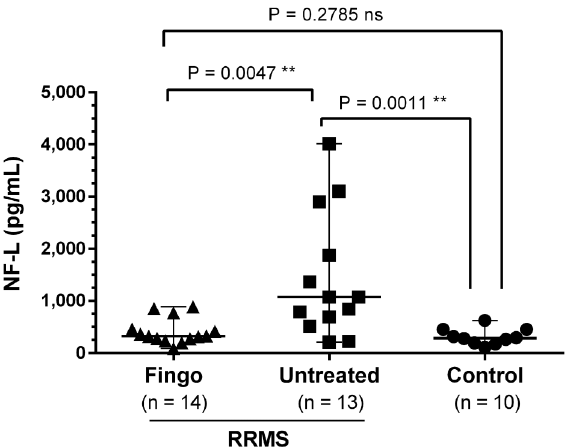
Figure 1. Level of neuro fi laments light chain (NF-L) in the cerebrospinal fl uid of control patients, untreated patients with relapse remitting multiple sclerosis (RRMS), and RRMS patients treated with fi ngolimod (Fingo) patients. Data are reported as median and range. Statistical analysis was carried out with the Kruskal-Wallis test, followed by the Mann-Whitney test. ns: not signi fi